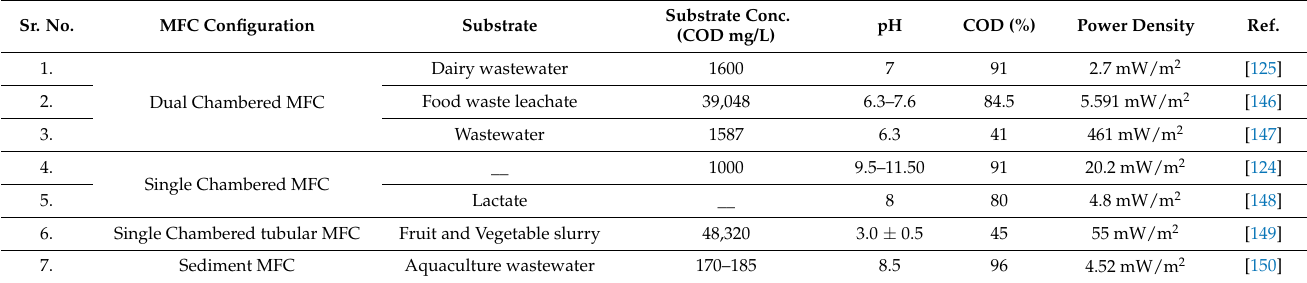
Table 4. Effect of pH and substrate concentration on MFC